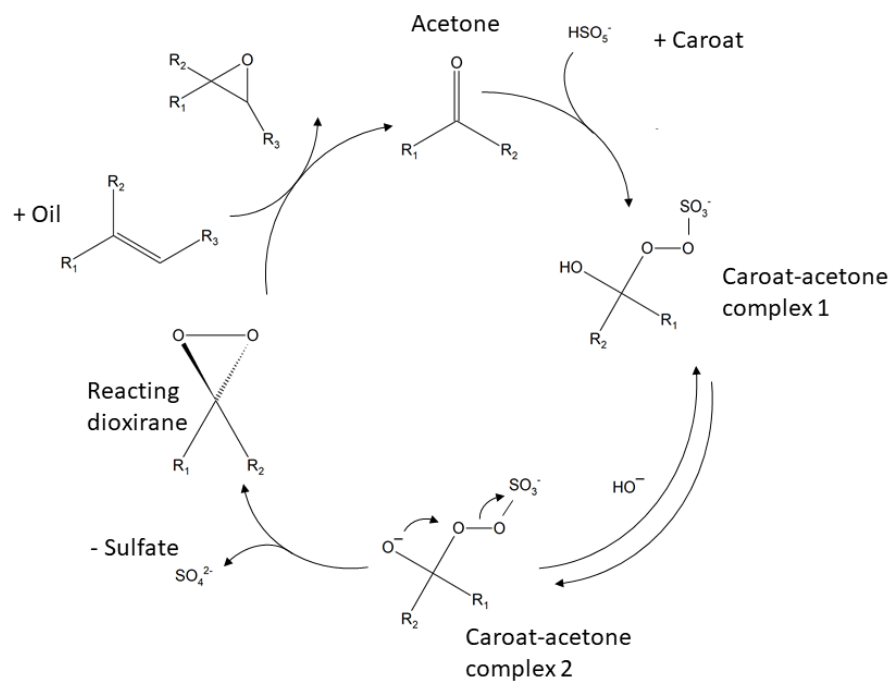
Figure 6. A redrawn illustration of the Caroat-acetone reaction cycle proposed by Shu and Shi (2000) [138].